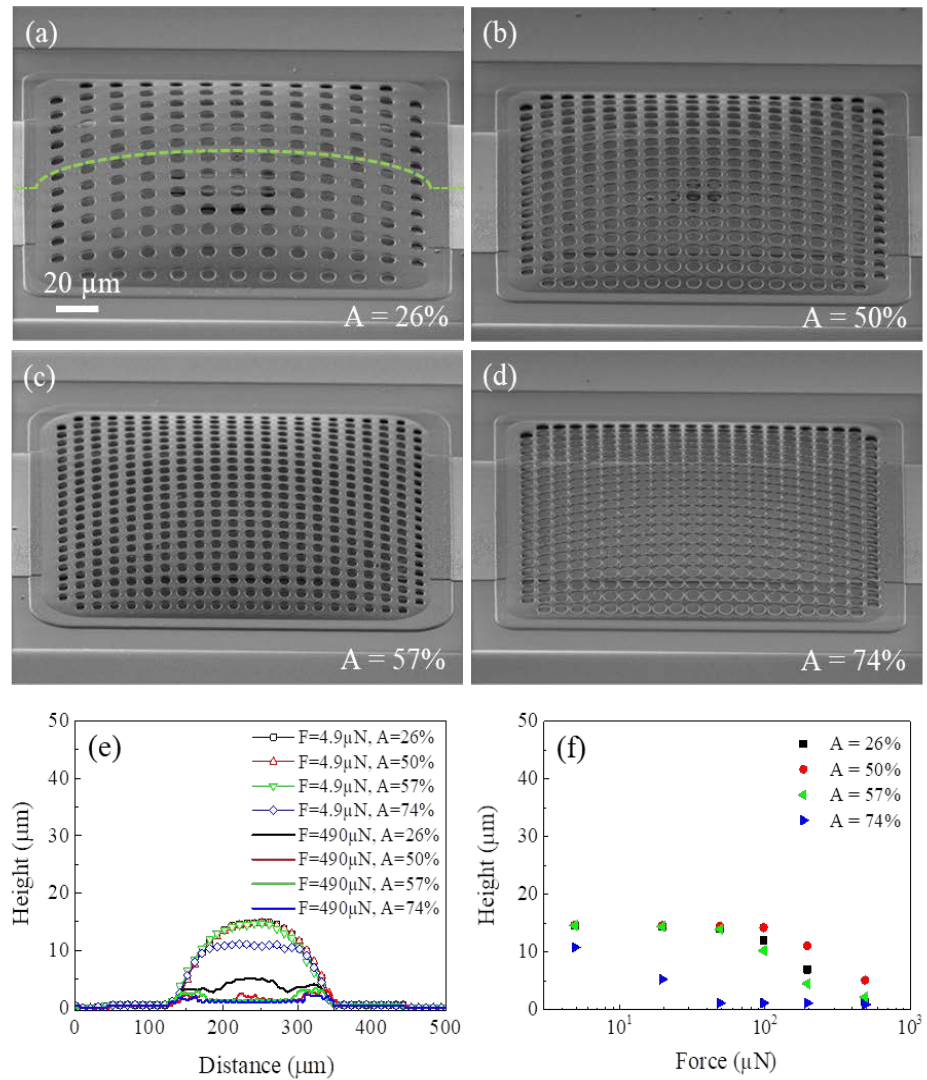
Figure 3. Tilted SEM images (tilt angle of 60°) of the fabricated encapsulating caps with A = 26% ( a ), 50% ( b ), 57% ( c ), and 74% ( d ). Profiles measured for caps in ( a )–( d ) under the application of a stylus tip force of 4.9 µN and 490 µN ( e ). Deflection in the center of the caps in ( a )–( d ) as a function of the stylus tip force ( f ). The marker is the same for all SEM images. The green line in (a) is the profiler scan line. Barrel parameters, which were used for the release of caps in ( a )–( d ), are P (power) = 600 W and t = 8 min.